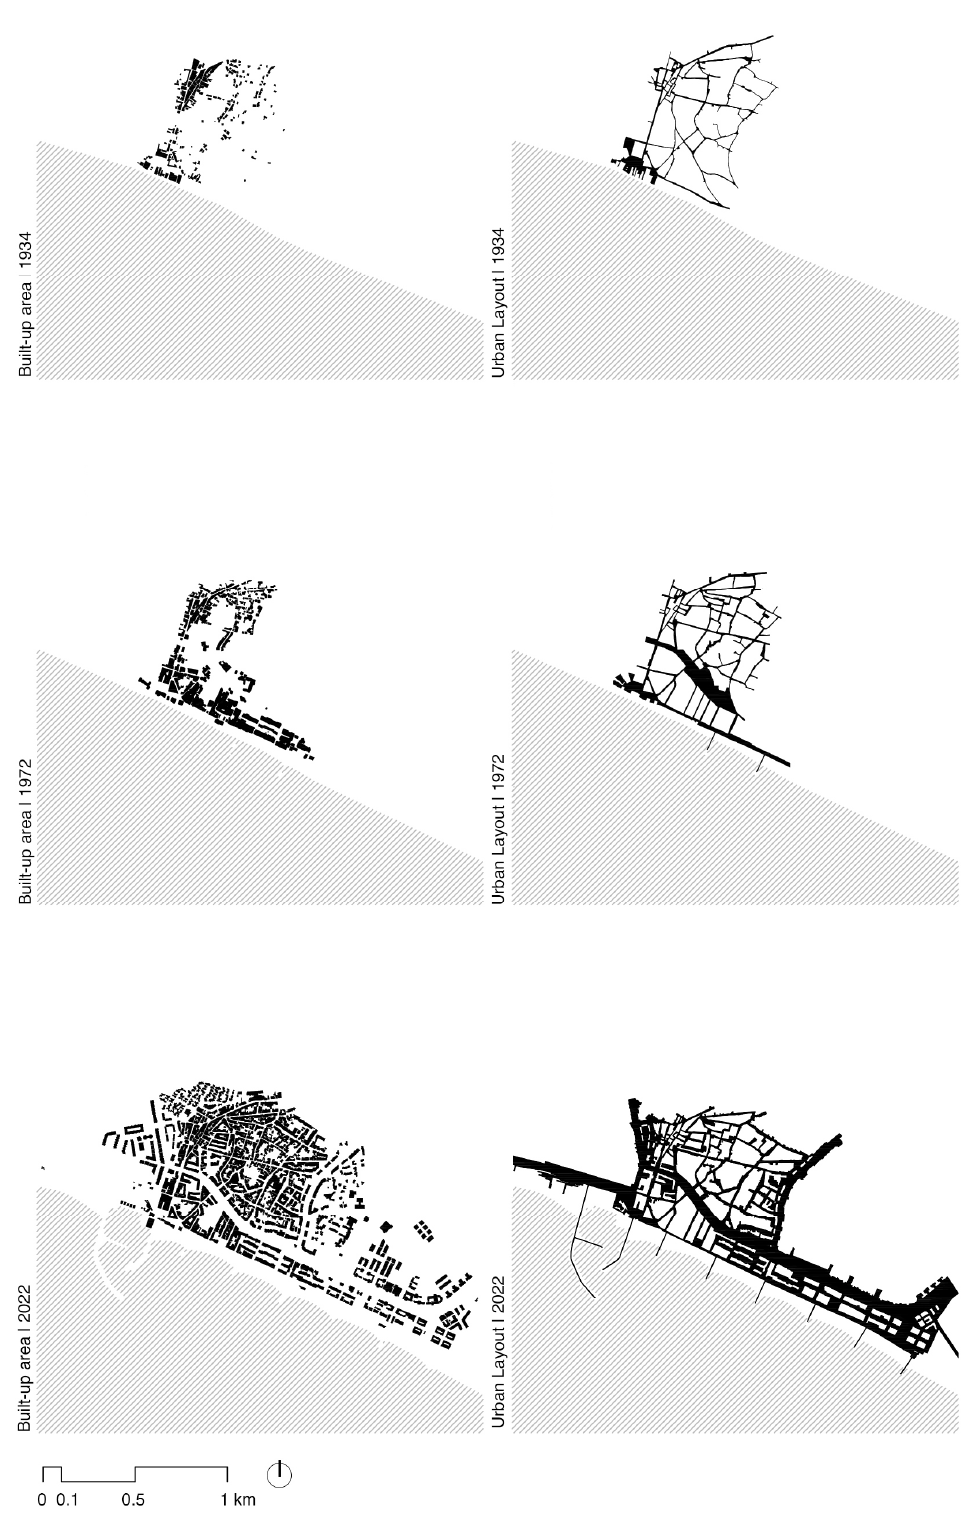
Figure 4. Quarteira. Morphological evolution: Urban Layout + Built fabric. Cartographic bases provided by Câmara Municipal de Loulé. Authors’ edition, 2022.